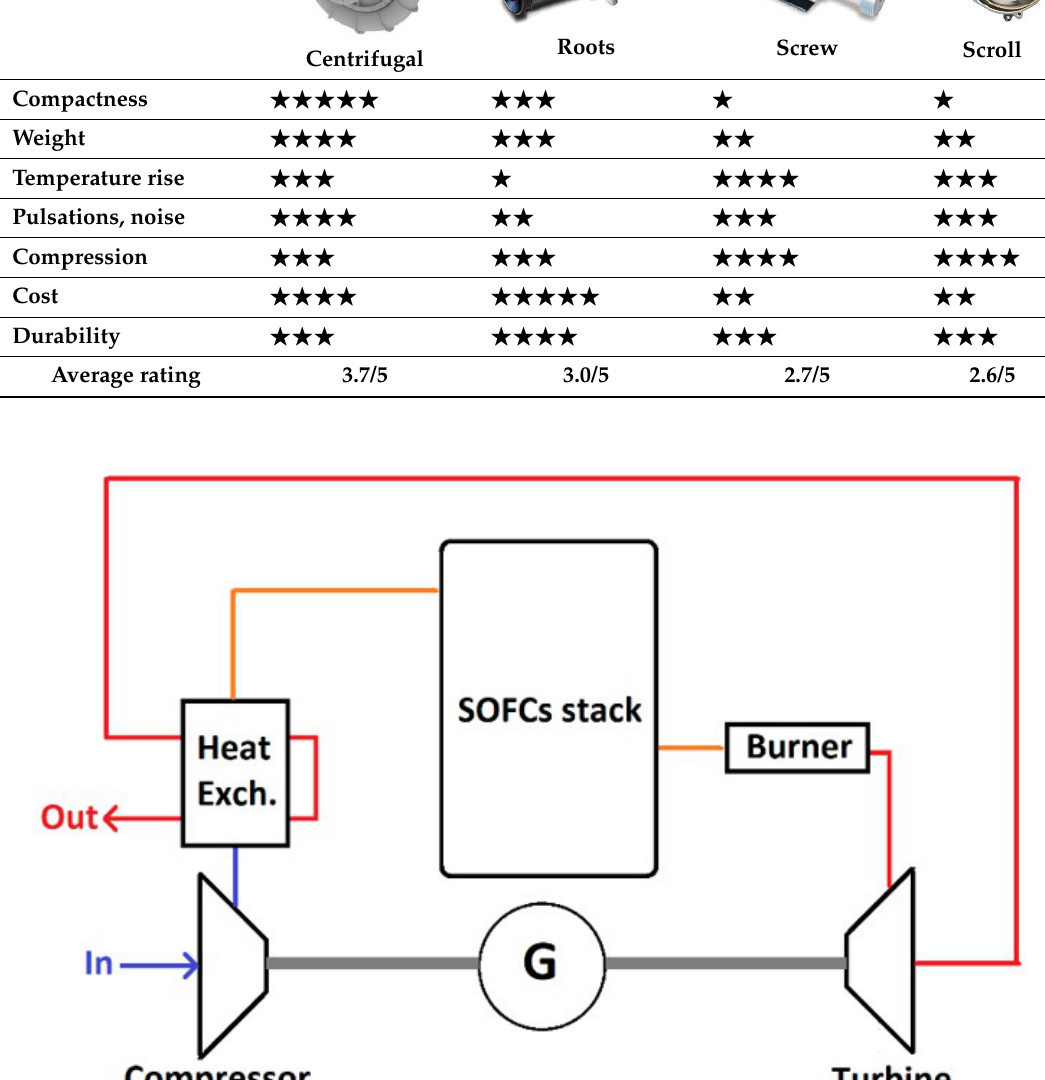
Figure 7. Example of a pressurised air supply system for an solid oxide fuel cell (SOFC) stack.